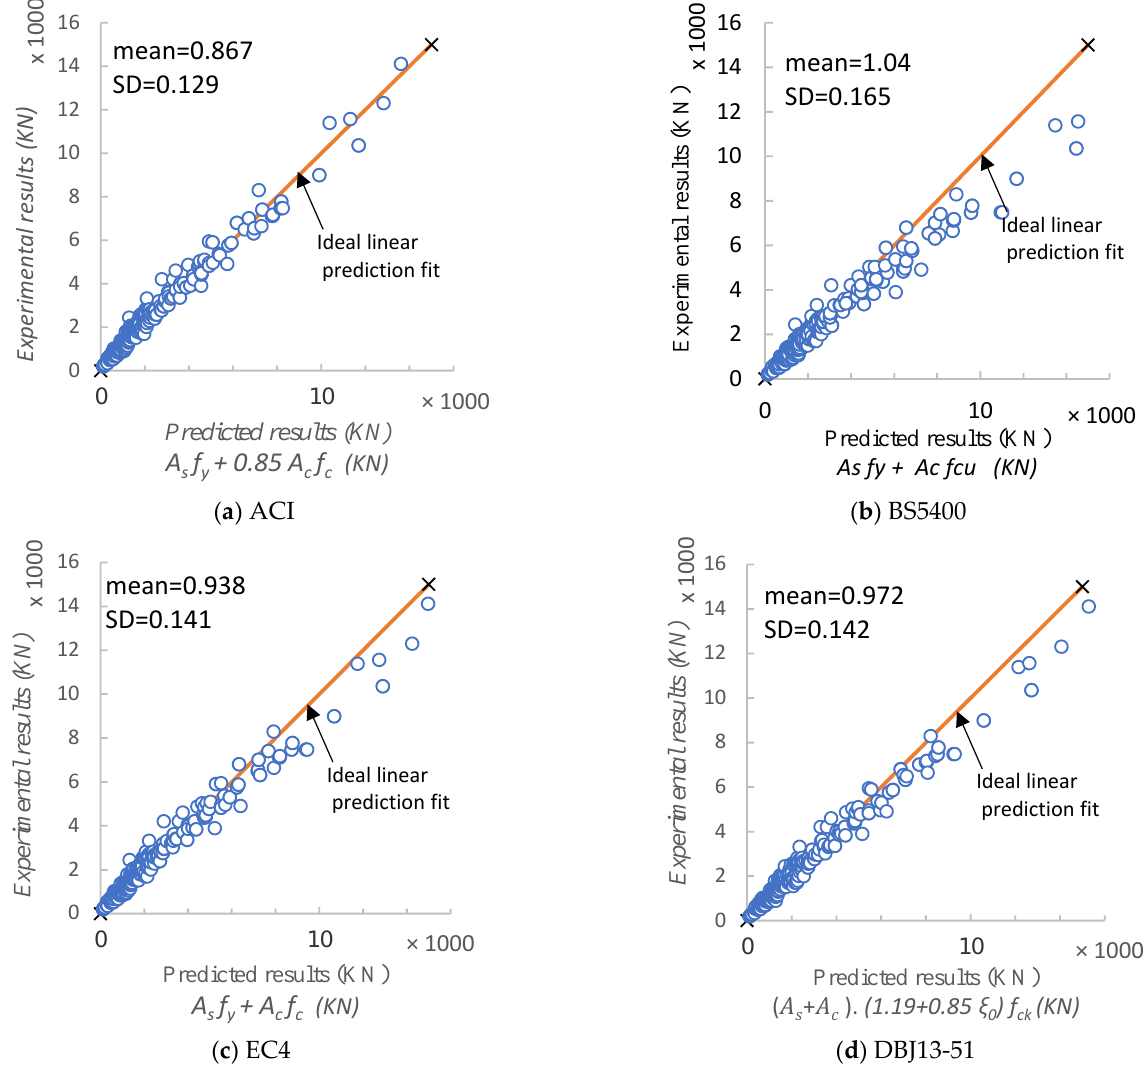
Figure 4. Comparison of the carrying capacity predictions of the different formulations.